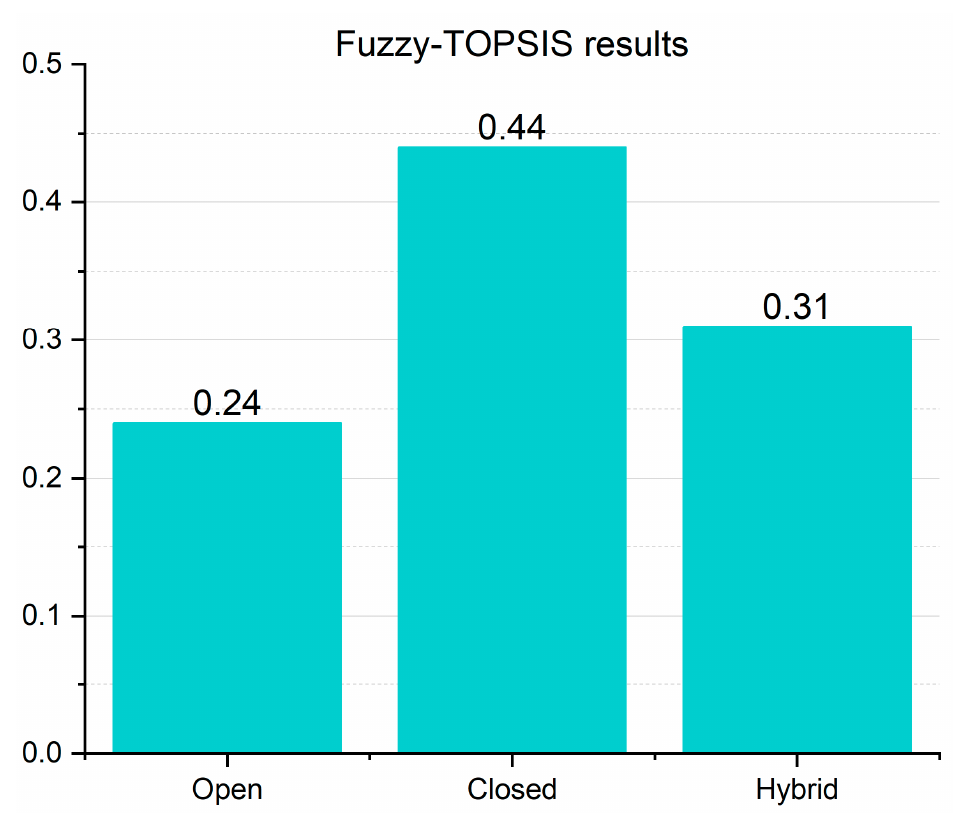
Figure 10. Results of technical impact; the higher is the greater.